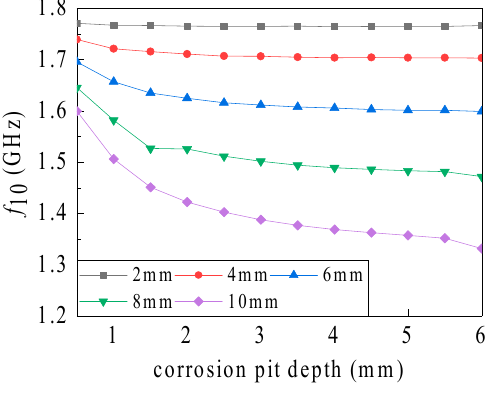
Figure 12. Influence of the volumetric corrosion pit depth on resonant frequency. Table 5. Identification sensitivity of the corrosion pit depth.